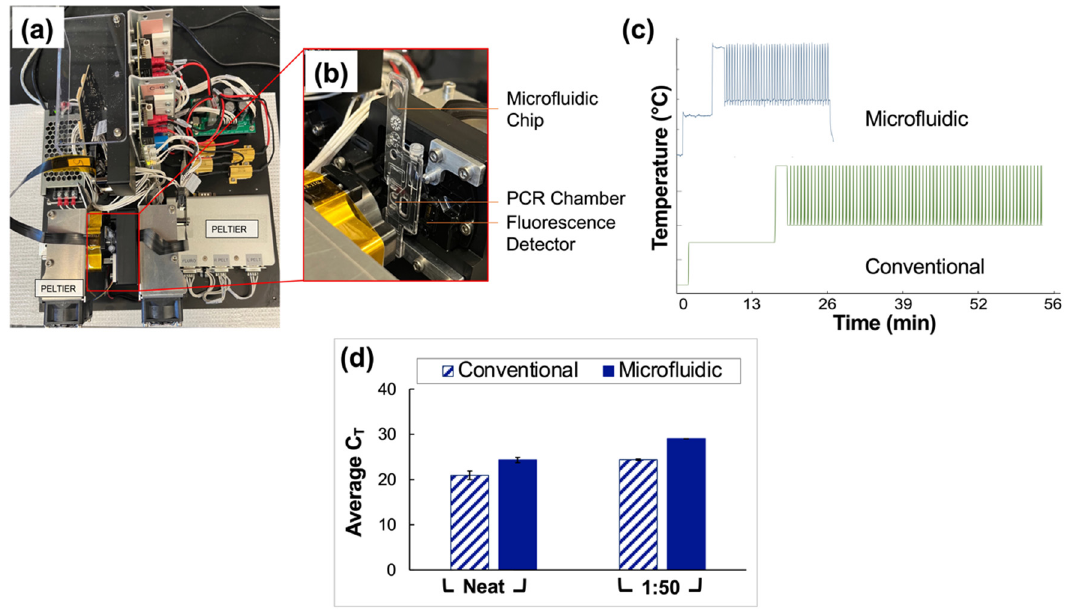
Figure 6. Comparison of conventional and microfluidic methods—Qiagen extraction and QuantStu- dio 5 RT-PCR vs. PDQeX extraction and amplification with ultra-rapid instrument, respectively. ( a ) Top view of the microfluidic instrument used for rapid PCR analyses. ( b ) Magnified and annotated view of the microfluidic chip as typically placed in the instrument for analyses. Before use of the device, this chip is sandwiched securely between two Peltiers to facilitate thermocycling, and the instrument is covered with a light-proof box. ( c ) Temperature profile expected for the conventional instrument (63 min runtime) compared to that obtained via thermocouple monitoring for the mi- crofluidic instrument (25 min runtime). ( d ) Summary of data obtained from a direct comparison of conventional and microfluidic methods (Qiagen extraction and QuantStudio 5 RT-PCR vs. PDQeX extraction and amplification using the ultra-rapid instrument, respectively. n = 3 in each case). The average C T values acquired using the conventional vs. microfluidic methods were statistically different (as determined by t -tests, p = 0.0060 for comparison of neat samples and <0.0001 for 1:50